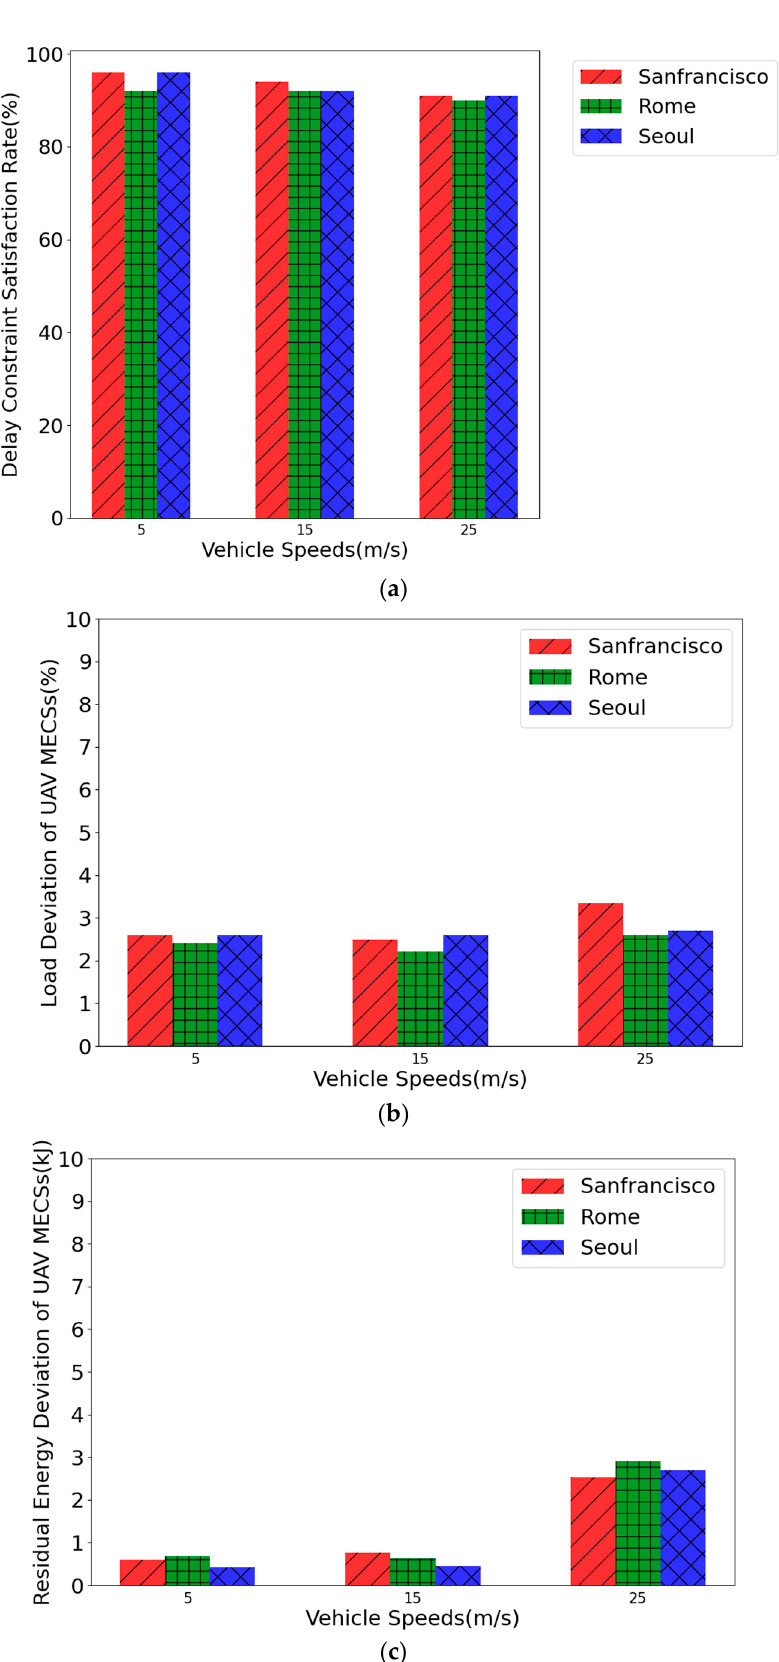
Figure 9. Experimental results with varying vehicle speeds in different environments: ( a ) delay con- straint satisfaction rate; ( b ) load deviation of UAV MECSs; ( c ) residual energy deviation of UAV MECSs.